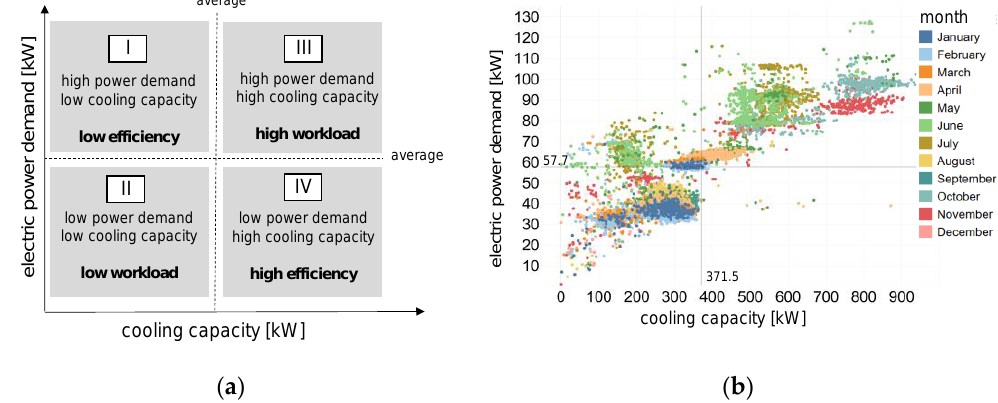
Figure 8. ( a ) Portfolio analysis to characterize energy efficiency ratio (EER) of CT inspired by the